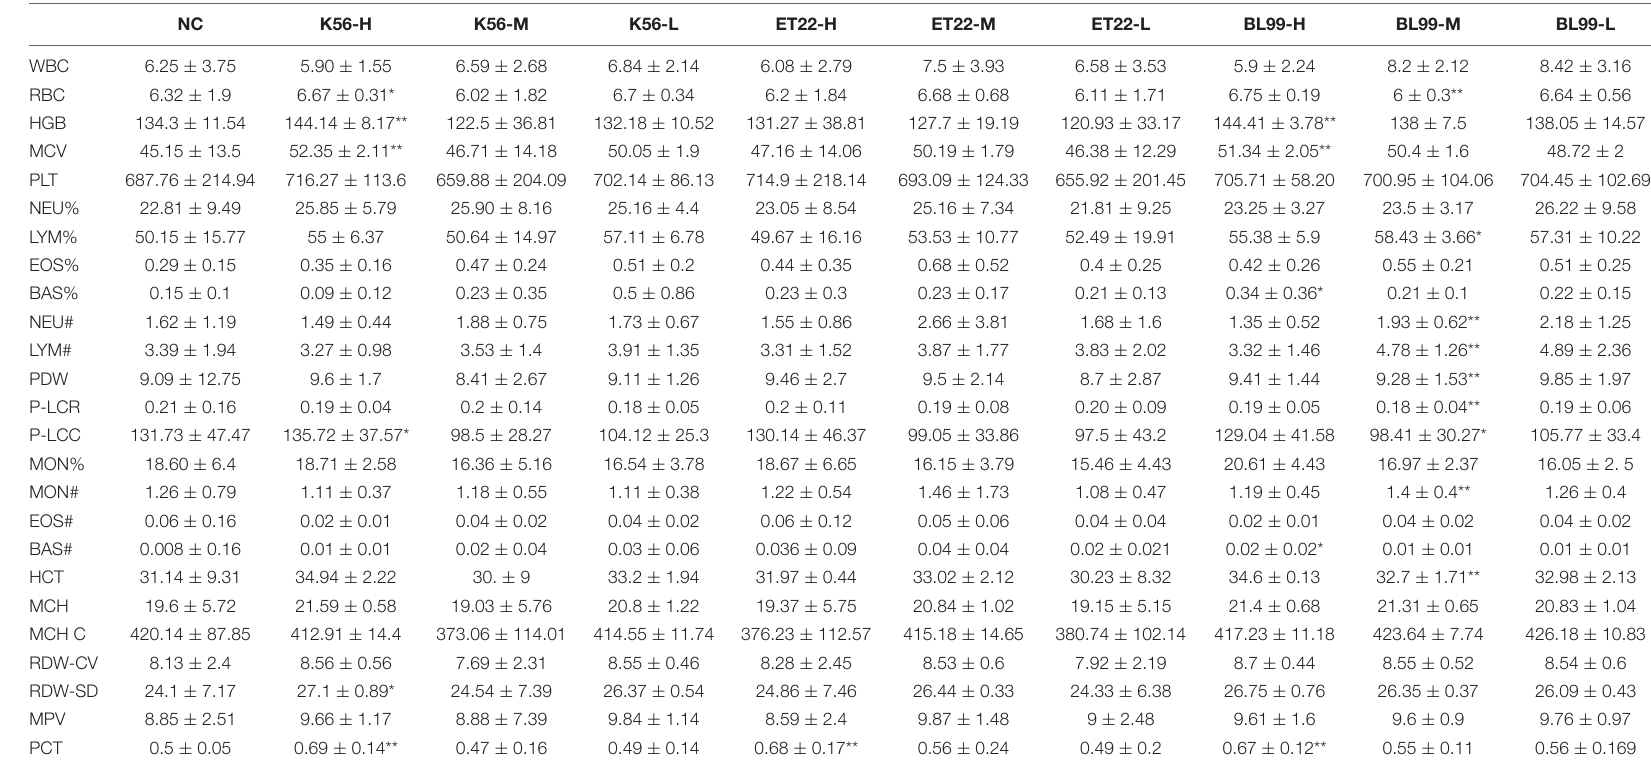
TABLE 5 | Changes of blood physiological